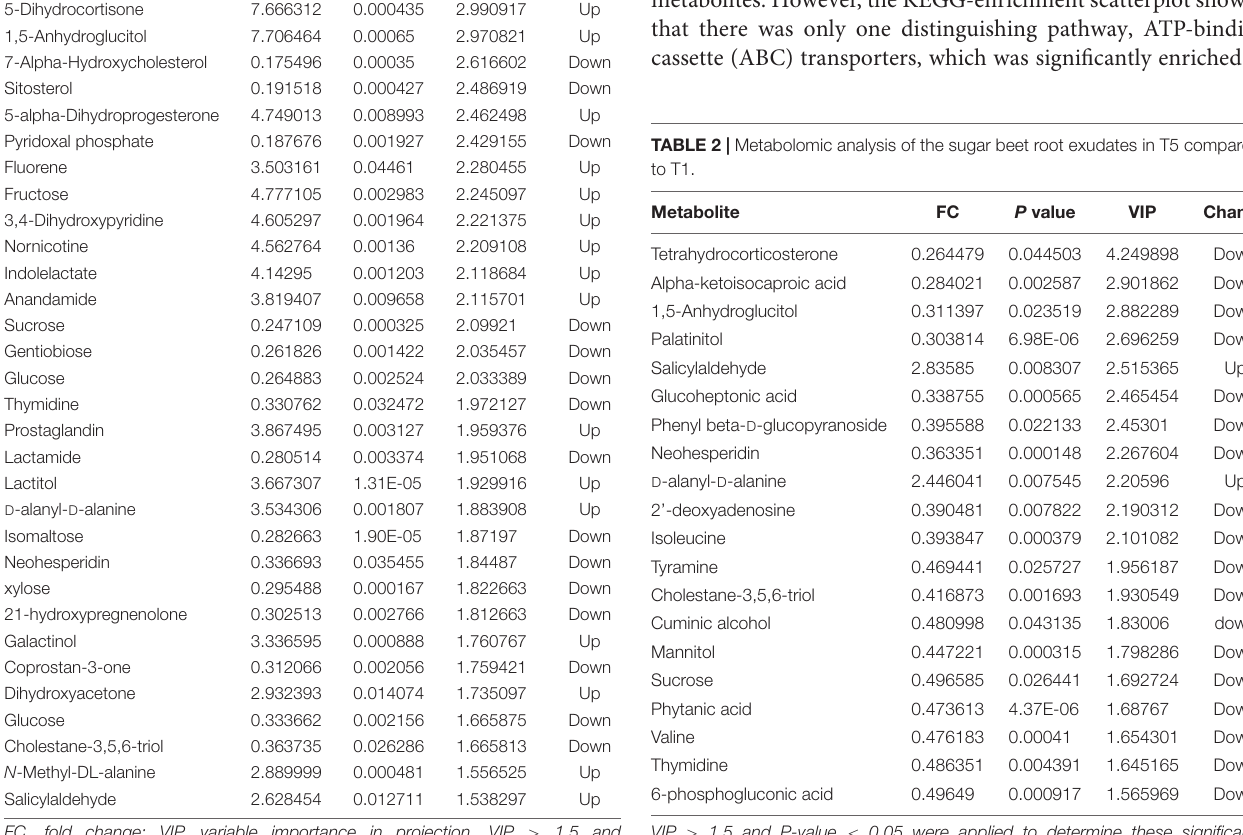
Salicylaldehyde was found to continuously accumulate in root exudates with the increasing years of continuous sugar beet